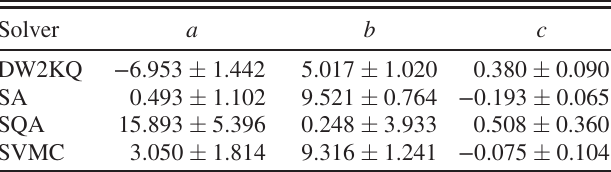
TABLE I. The coefficient ð a; b; c Þ in fits of ln h TTS i (cid:3) to a þ b ln L þ cL for the hardware-planted instances using L ∈ ½ 8 ; 16 (cid:2) . Errors are 95% confidence